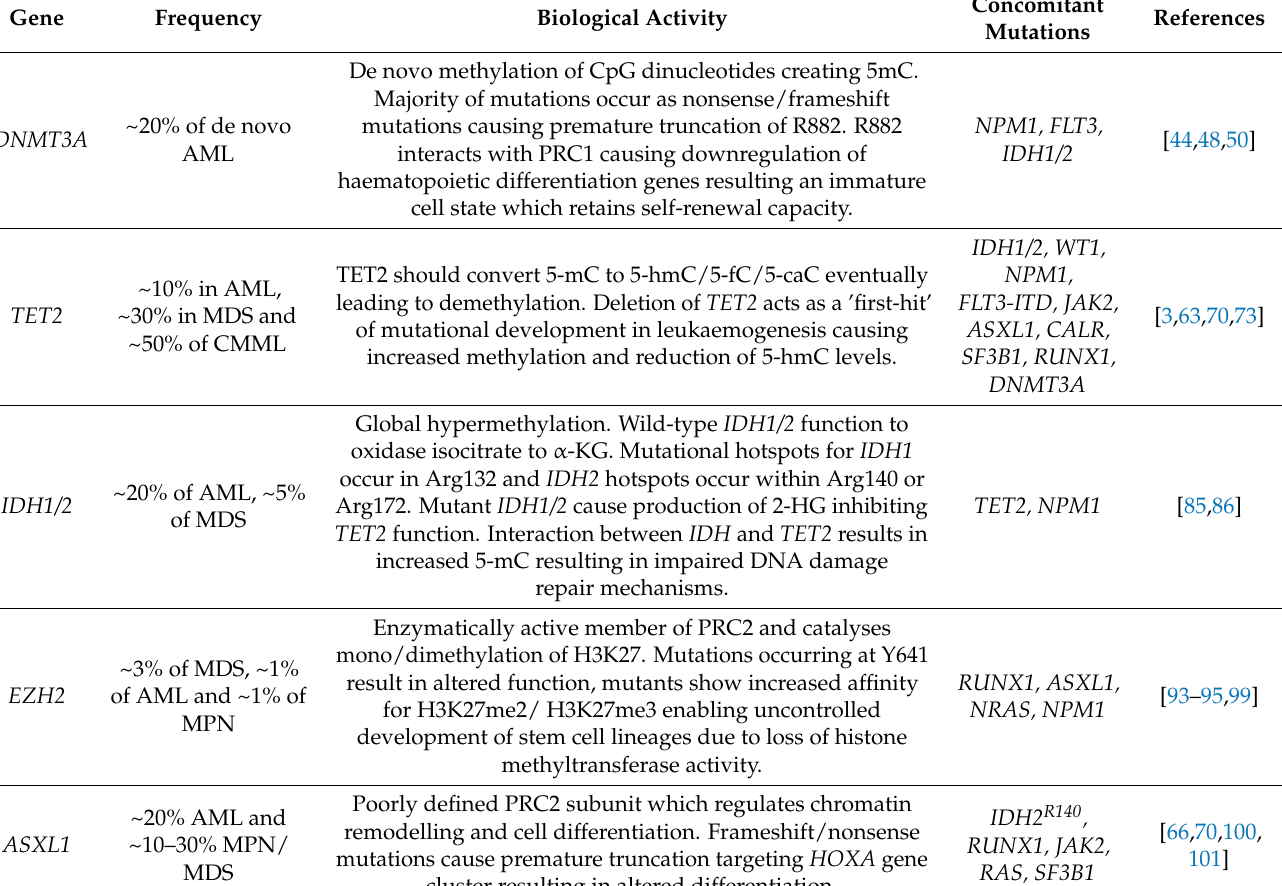
Table 2. Table summarizing the epigenetic modifiers including frequency within disease, biological activity, and concomitant mutations. R882- Arginine 882. 5-mC- 5-methylcytosine. 5-hmC- 5-hydroxymethylcytosine. 5-fC- 5-formylcytosine. F-caC- 5-carboxylcytosine (5-caC). α -KG- α -ketoglutarate. 2-HG- 2-hydroxyglutarate. PRC2- Polycomb repressive complex 2. H3K27- Histone 3 Lysine